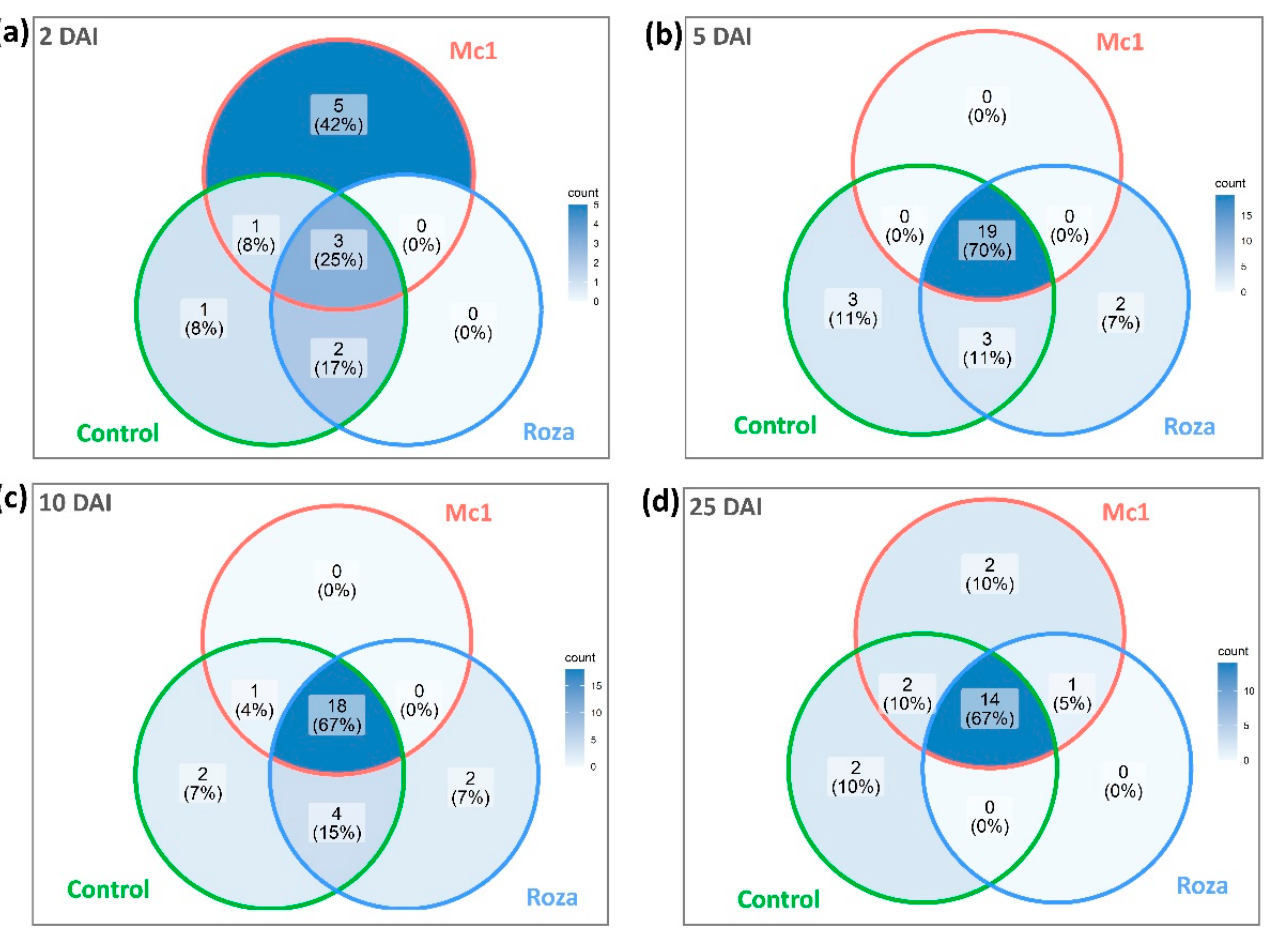
Figure 1. Venn diagrams showing common and unique peaks represented by different retention times extracted from GC-FID data of wild potato species, SB22 plants infected with M. chitwoodi Race 1 (Mc1), and its pathotype Roza across different days after inoculation (DAI). ( a ) 2 DAI, ( b ) 5 DAI, ( c ) 10 DAI, and ( d ) 25 DAI.